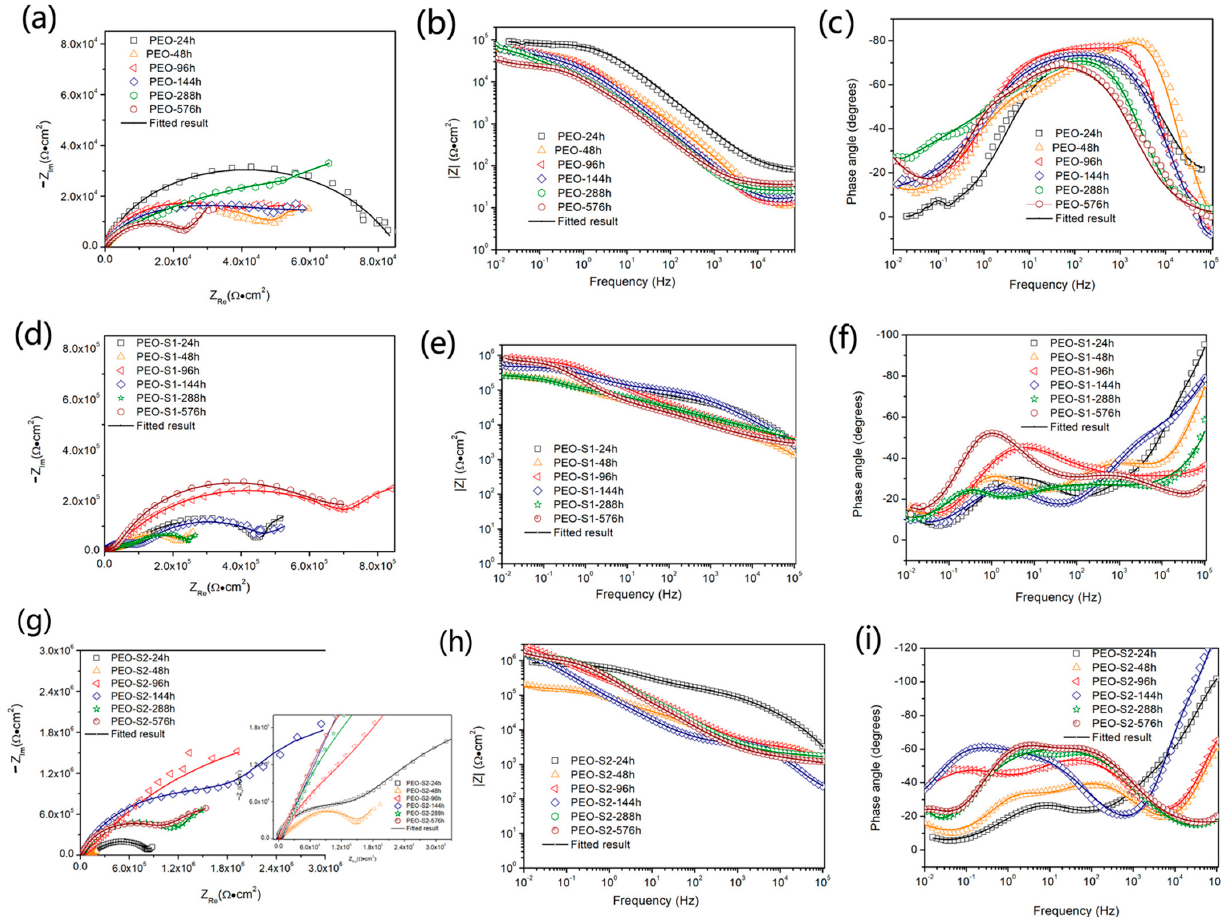
Figure 6. Nyquist and Bode plots for the coatings on UNS A97075 alloy immersed in a 3.5 wt.% NaCl solution: ( a – c ) PEO coating; ( d – f ) PEO-S1 coating; and ( g – i ) PEO-S2.